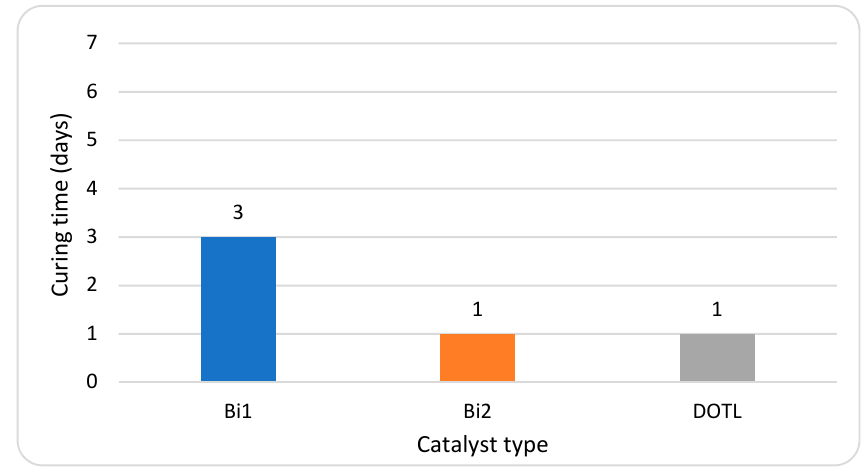
Figure 9. Effect of catalysts on cure time of formulated SPUR samples.